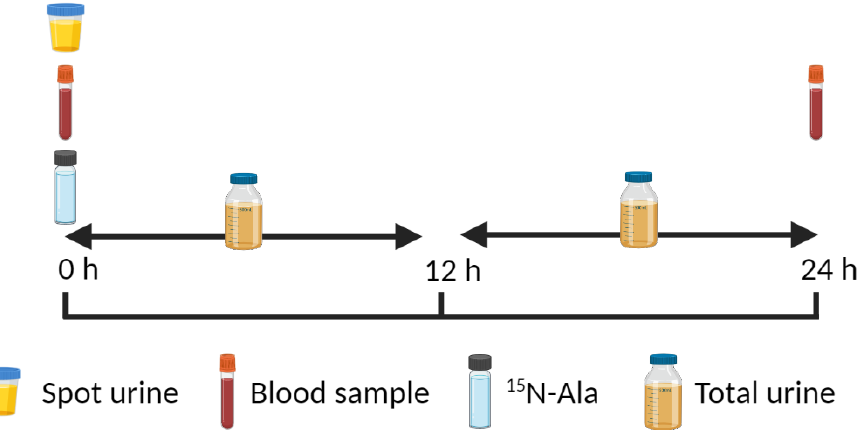
Figure 4. Example of a study protocol to measure whole-body protein metabolism using the N end-product method. Created with BioRender.com. end-product method. Created with